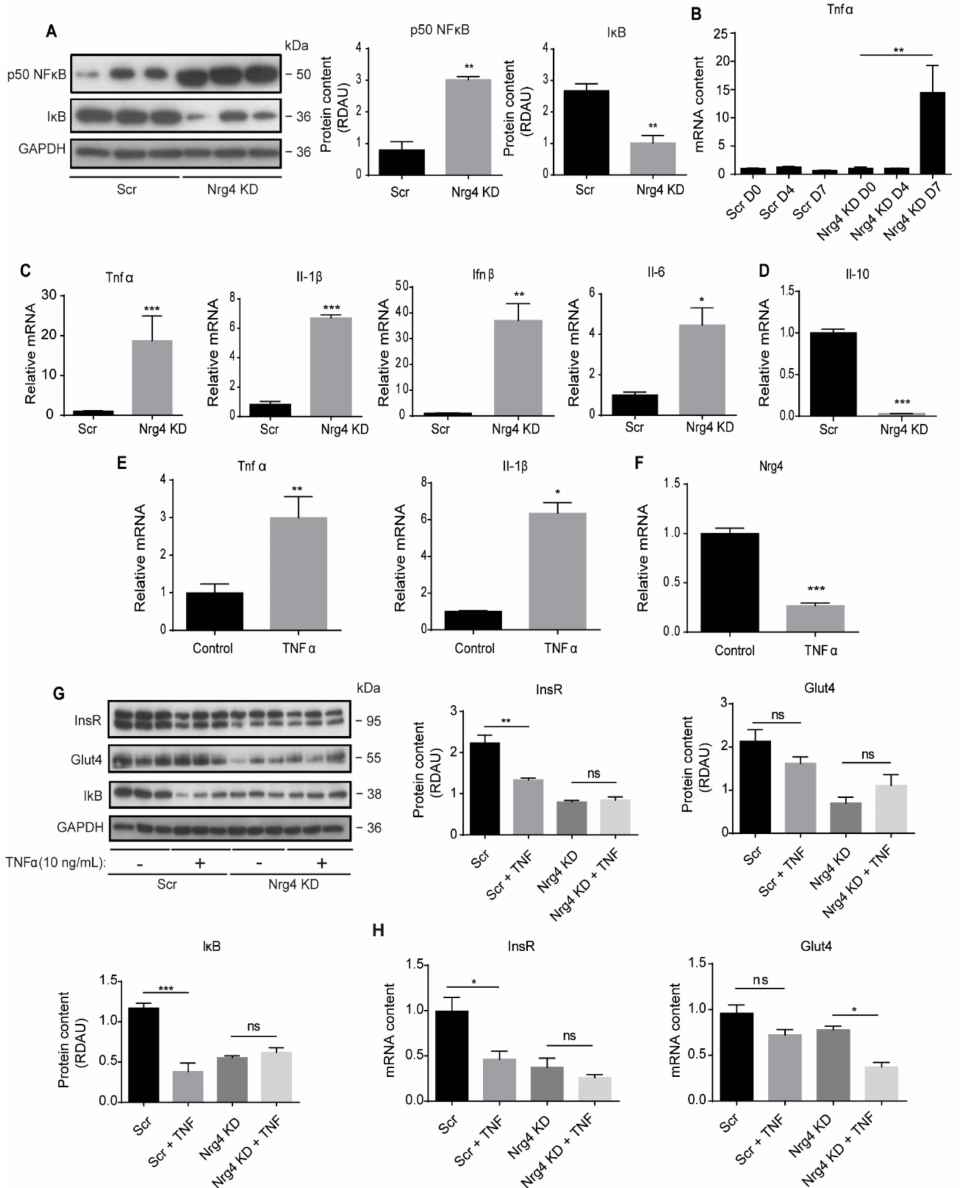
Figure 3. Cell-autonomous inflammation in Nrg4 knockdown adipocytes. ( A ) Western blot bands and quantification of p50 NF- κ B and I κ B, relative to GAPDH, in Scr and Nrg4 KD adipocytes at day 7 (D7) of differentiation ( n = 3). Each lane represents an independent experiment. ( B ) Tnf α expression during differentiation in Scr and Nrg4 KD cells ( n = 3). Data were normalized to Scr D0 preadipocyte expression. ( C ) Expression of the NF- κ B target genes Tnf α , Il-1 β , Ifn β , Il-6, and ( D ) expression of the anti-inflammatory cytokine Il-10 in Scr and Nrg4 KD adipocytes at D7 ( n = 3). Data were normalized to Scr D7 expression. ( E , F ) Tnf α , Il-1 β , and Nrg4 expression in TNF α -treated and non-treated (Control) 3T3-L1 adipocytes at D7 ( n = 3). Adipocytes were treated with 10 ng/mL TNF α for 24 h at D6. Data were normalized to non-treated control adipocyte expression at D7. ( G ) Western blot bands and quantification of InsR, Glut4, and I κ B in TNF α -treated and non-treated Scr and Nrg4 KD adipocytes at D7 ( n = 3). The lower band of the InsR blot was quantified. Overall contrast and brightness of the western blots were adjusted to clarify the images. ( H ) InsR and Glut4 expression in TNF α -treated and non-treated Scr and Nrg4 KD adipocytes at D7 ( n = 3). Data were normalized to non-treated Scr adipocytes. Data represent mean ± SEM. * p ≤ 0.05, ** p ≤ 0.01, *** p ≤ 0.001, ns (not